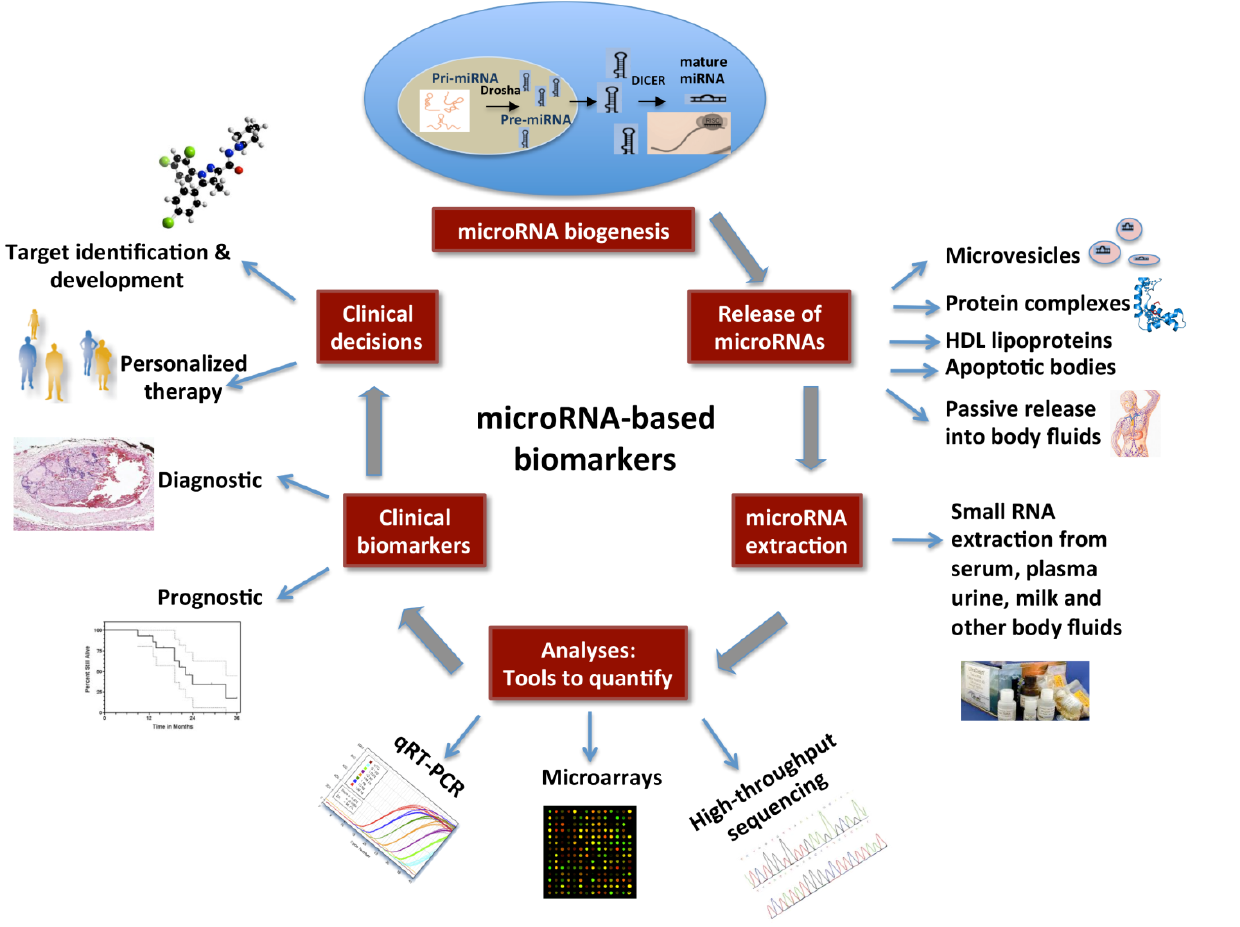
Figure 1. Circulating microRNAs as biomarkers: A schematic diagram showing miRNA biogenesis, modes of their secretion into body fluids, RNA extraction and quantitative approaches. In future, clinical decisions may be made based on the expression levels of miRNAs. This figure is adapted from Steer and Subramanian